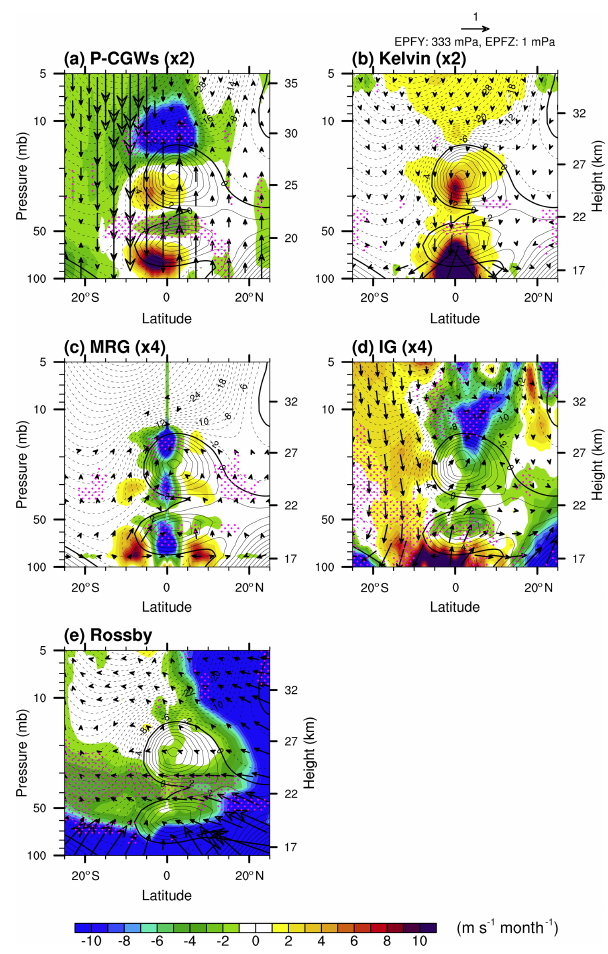
Figure 2. Latitude–height cross sections of the EPF (vectors) and EPD (shading) for the (a) parameterized CGWs (P-CGWs, mul- tiplied by 2) and resolved equatorial waves, including (b) Kelvin (multiplied by 2), (c) MRG (multiplied by 4), (d) inertia–gravity (IG, multiplied by 4), and (e) Rossby waves, superimposed on the zonal-mean zonal wind (contour) in February 2016. Positive (nega- tive) zonal winds are plotted with solid (dashed) lines with a contour interval of 2ms − 1 , and thick contour lines denote a zero zonal wind speed. The magenta stippled pattern represents a region where the EPD is algebraically smaller (more negative) than the climatology by more than its SD. The arrow in the upper right corner denotes the reference